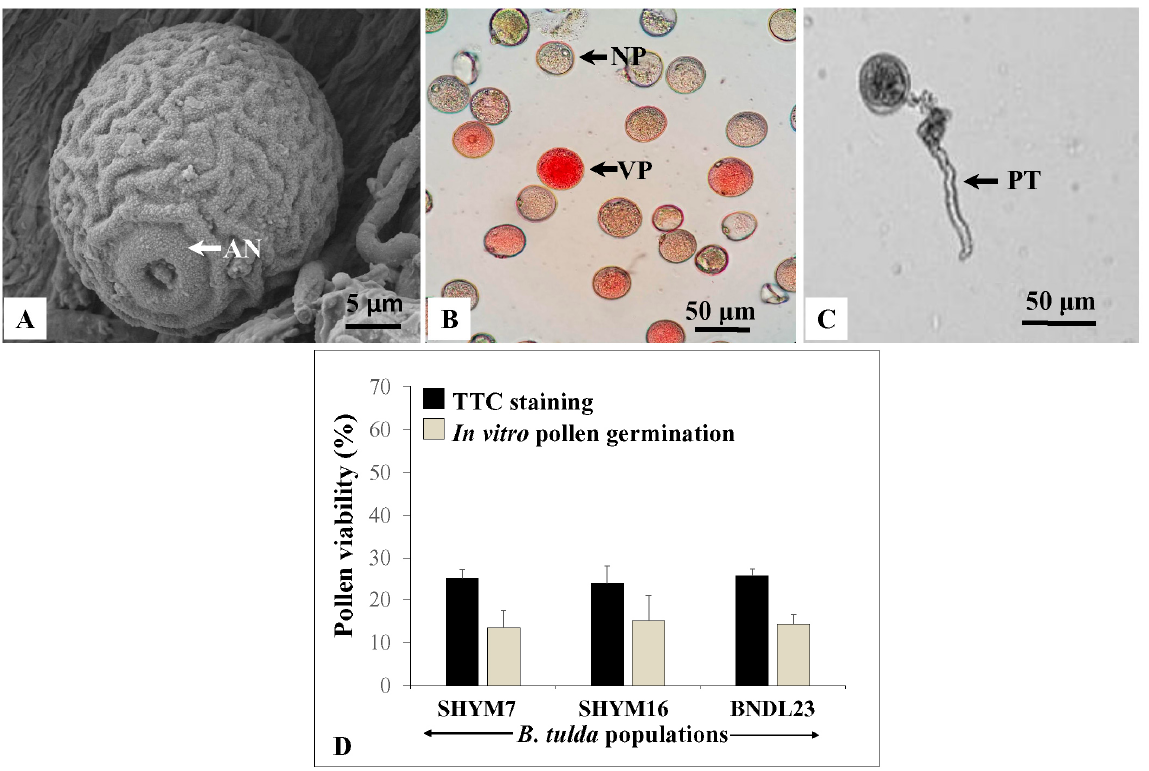
Figure 6. Studies on pollen morphology and viability. ( A ) SEM image of a monoporate pollen having granular exine. ( B ) Pollen grains stained using 2,3,5 triphenyl tetrazolium chloride (TTC) and ( C ) Germinated pollen grain. ( D ) Bargraph of the pollen viability based on TTC staining (black bar) and germination assay (grey bar). Pearson’s chi-squared test revealed that the differences in proportion were statistically not significant across B. tulda populations for both TTC and